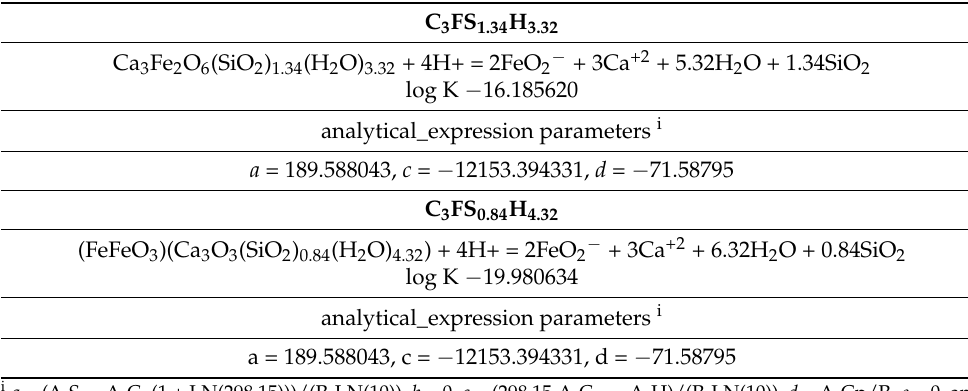
Table 7. Si-hydrogarnet end-member properties [25].